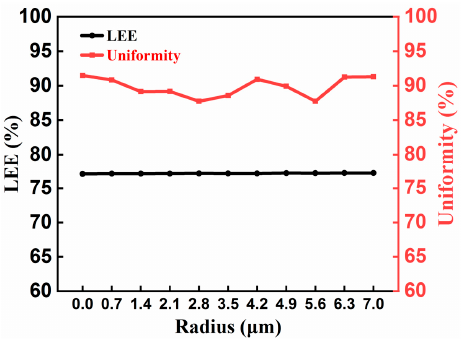
Figure 7. Relationships between the “tip” radius of the cone-shaped light coupling microstructure and the LEE and uniformity. and the LEE and uniformity.